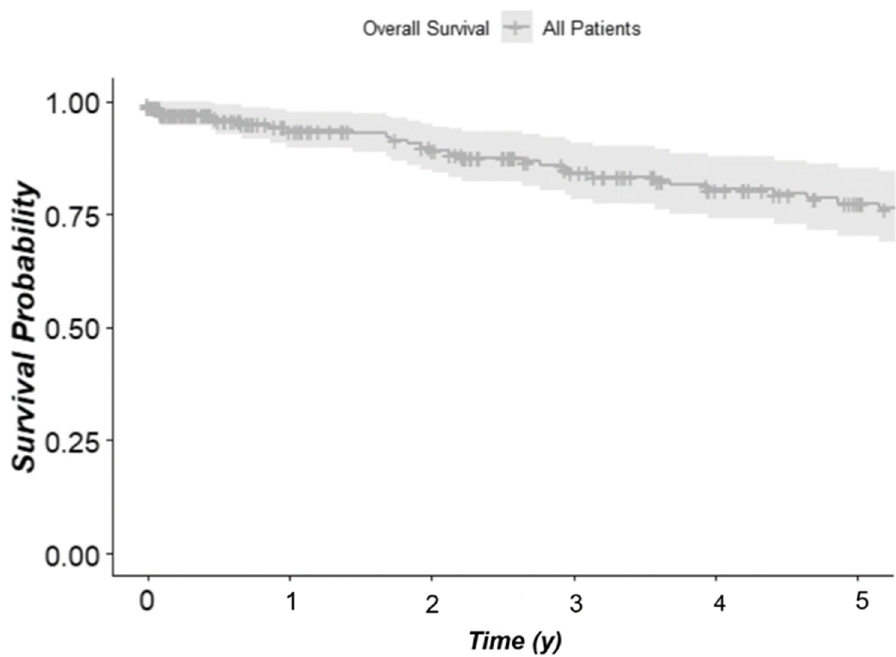
Figure 2. Survival probability, Kaplan–Meier analysis; median overall survival (mOS) was 17.13 years (95%-CI: 8.99–NA years (95%—CI: 8.99–NA years).